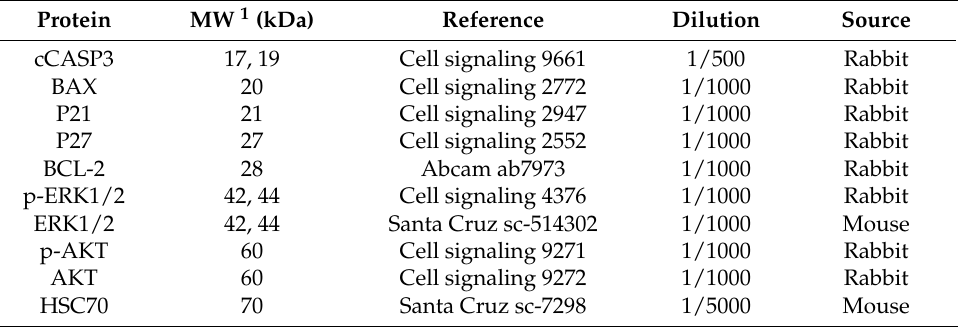
Table 1. List of the antibodies used for Western